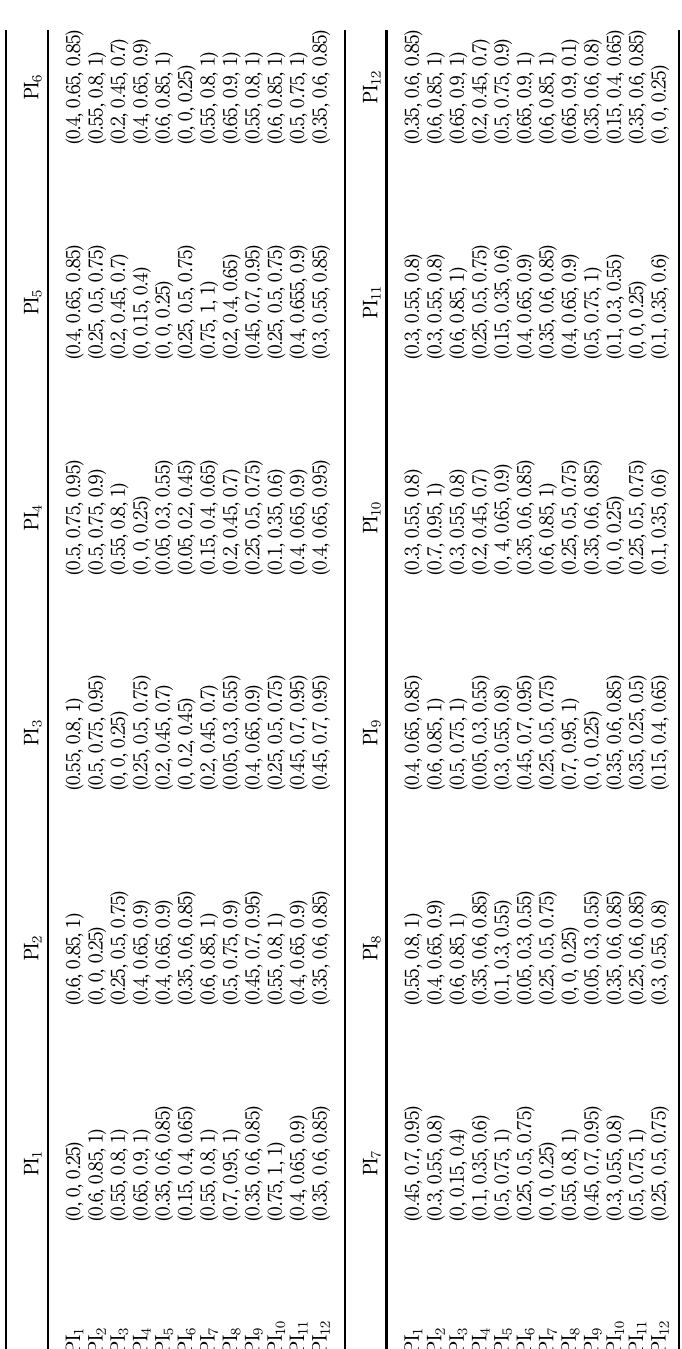
Table A6. The fuzzy initial direct relation matrix